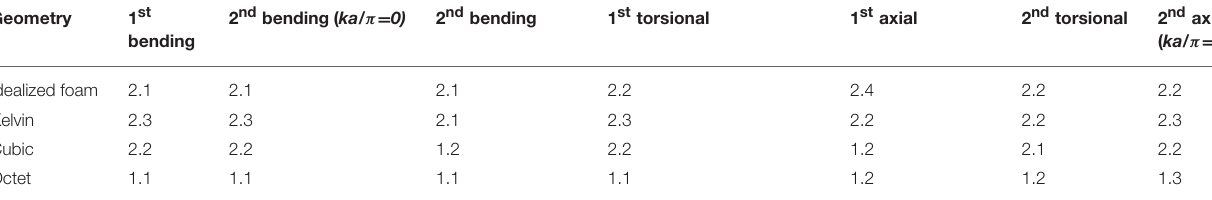
TABLE 4 | Scaling exponents for power-law approximations of modal stiffness vs. relative density. Geometry